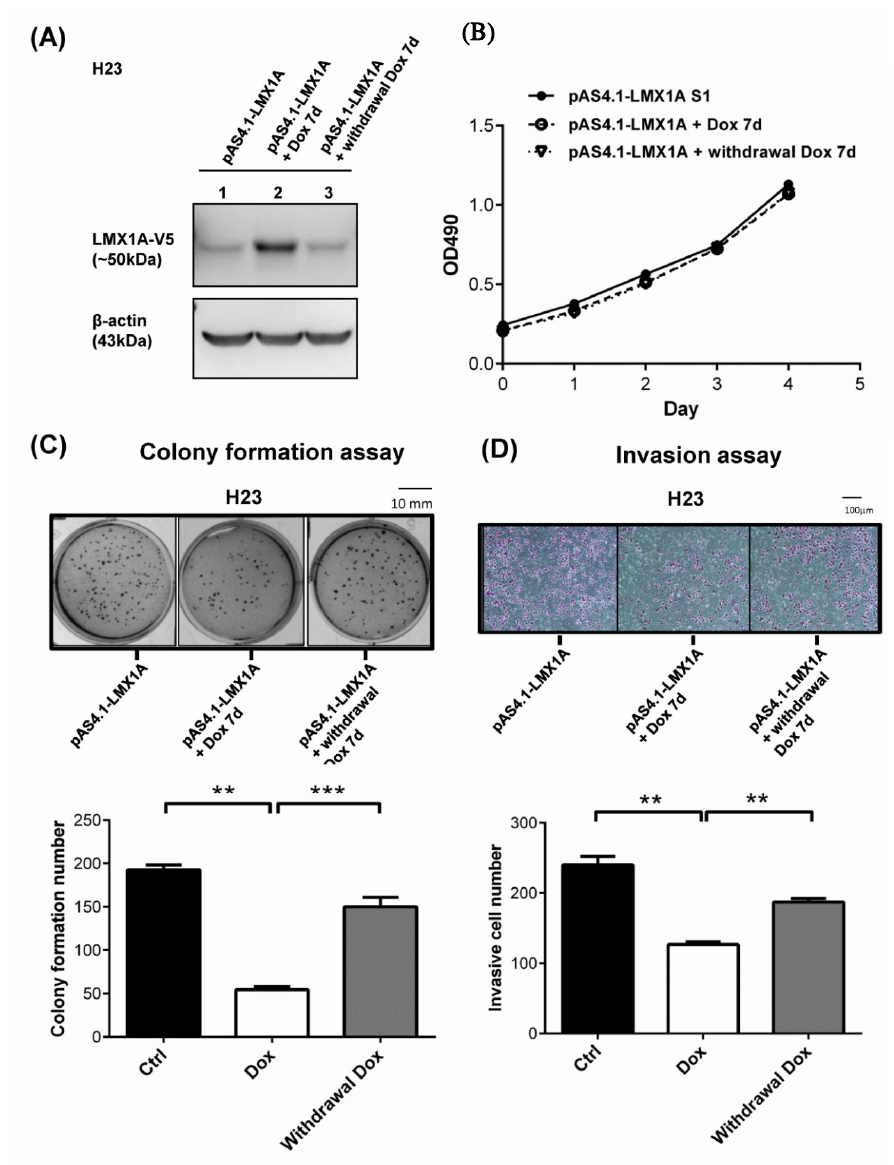
Figure 5. LMX1A suppresses the colony formation and invasion of cancer cells in an inducible expression system. ( A ) Doxycycline (Dox; 1 ng / µ L)-inducible LMX1A expression was established in H23 cells and was assessed by Western blot analysis. β -Actin was used as an internal control. ( B – D ) Cells treated with Dox (1 ng / µ L) for 7 days or withdrawn from Dox treatment for another 7 days were tested for cell proliferation (MTS) ( B ), colony formation ( C ), and invasion ( D ). The results are presented as the mean ± SEM from three independent experiments in duplicate. ** p < 0.01 and *** p < 0.001 (Mann–Whitney U test or Student’s t -test).